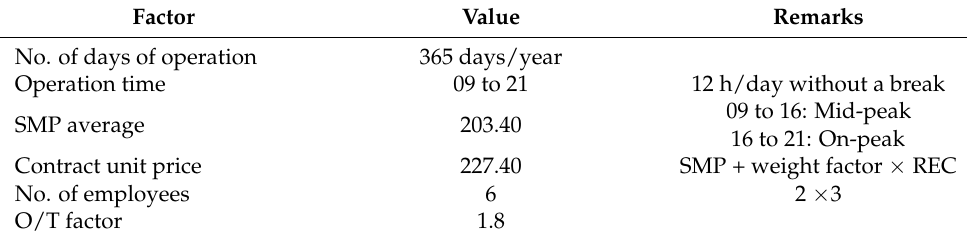
Table 31. Factors and their values are subject to the operation plan (Scenario V).